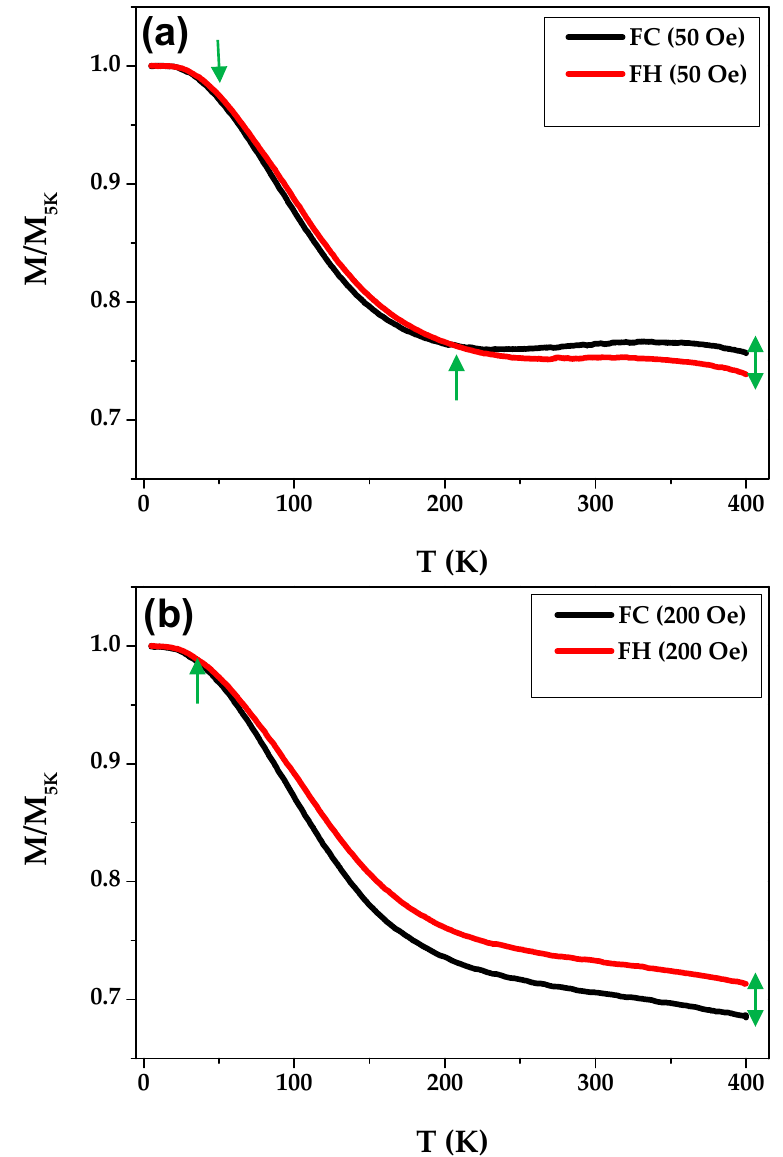
Figure 5. Measured temperature dependence on magnetization for the as-prepared Co 2 MnGe glass- coated microwires, with 50 Oe ( a ) and 200 Oe ( b ) of applied external magnetic field. The thermomagnetic properties, i.e., M/M 5K vs. T, and magnetic field of the Co 2 MnGe glass-coated microwires, are shown in Figures 5 and 6. In this part, we only focused on the magnetization behavior at a wide range of temperatures and magnetic fields to evaluate the possible magnetic phase transition. We measured temperature dependencies of the magnetization in the temperature, T, range from 5 to 400 K. To avoid the over estimation of the magnetization, we used normalized magnetization parameters (M/M 5K ), where the M 5K is the highest magnetic moment detected at 5 K. Notable ferromagnetic behavior has observed for all ranges of measured temperatures and applied magnetic fields, which is expected due to the high Curie temperature for the Co 2 MnGe alloy above 883 K [16,37]. For field cooling (FC) and field heating (FH) magnetization curves, a notable mismatching between FC and FH curves has been observed when (M/M 5K vs. T) the dependence was measured at a low magnetic field, i.e., 50 Oe and 200 Oe, as seen in Figure 5. For the M/M 5K (T) curves measured at 50 Oe, the FC curve overlapped FH curves at a temperature range of 400 K to 200 K, then reversed at a temperature range of 200 K to 30 K. Finally, full